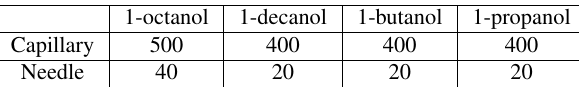
Table 2. Minimum values of the flow rate measured in (cid:22) l / h for the standard feeding capillary and the hypodermic